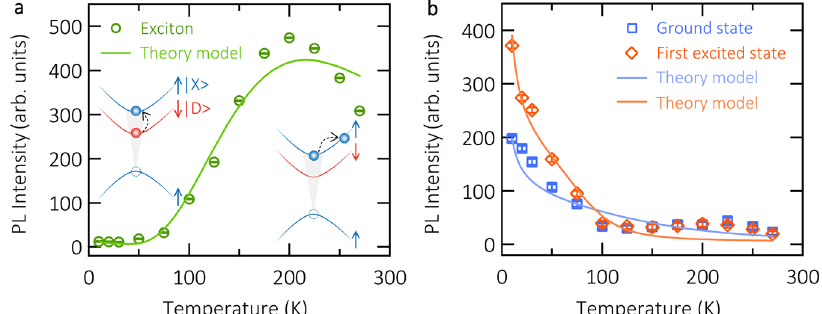
Fig. 4 Integrated PL intensity of bare excitons and exciton-polaritons as a function of temperature. a Temperature-dependent emission intensity of bare excitons in pristine WSe 2 monolayer. The experimental data are shown as green circles, and the corresponding integration regions are marked as dashed boxes in Fig. 3a – c. The solid curve represents the result of a theoretical modelling (see main text). The mechanism of PL intensity for different temperature ranges is shown as insets: thermal activation (10 – 200 K) and relaxation into momentum-forbidden dark states (200 – 270K). b Temperature-dependent PL emission intensity of exciton-polaritons. The experimental data of the ground state and fi rst excited state are shown as blue squares and red diamonds, respectively. The integration region of the ground state ( fi rst excited state) is indicated with a dashed (dotted) box in Fig. 3g – i. The solid curves are fi ts of the theory model. The strong PL intensity at low temperatures evidences the brightening effect of intrinsically dark exciton. The error bars are obtained by comparing the signal intensity to the standard deviation of the background noise.